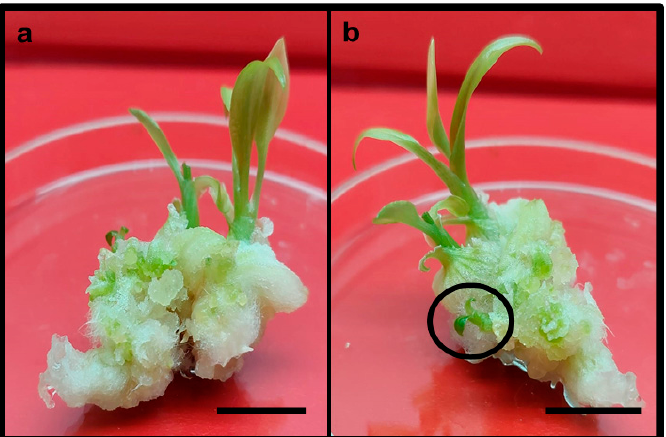
Figure 3. ( a ) Callus produced from the treatment MSB5 medium supplemented with 15 μ M BAP and 5 μ M 2-iP at eight weeks after inoculation. ( b ) Regenerated shoot (in circle) from the treatment MSB5 medium supplemented with 15 μ M BAP and 5 μ M 2-iP at eight weeks after inoculation. Scale bars represent 1 cm of actual size.